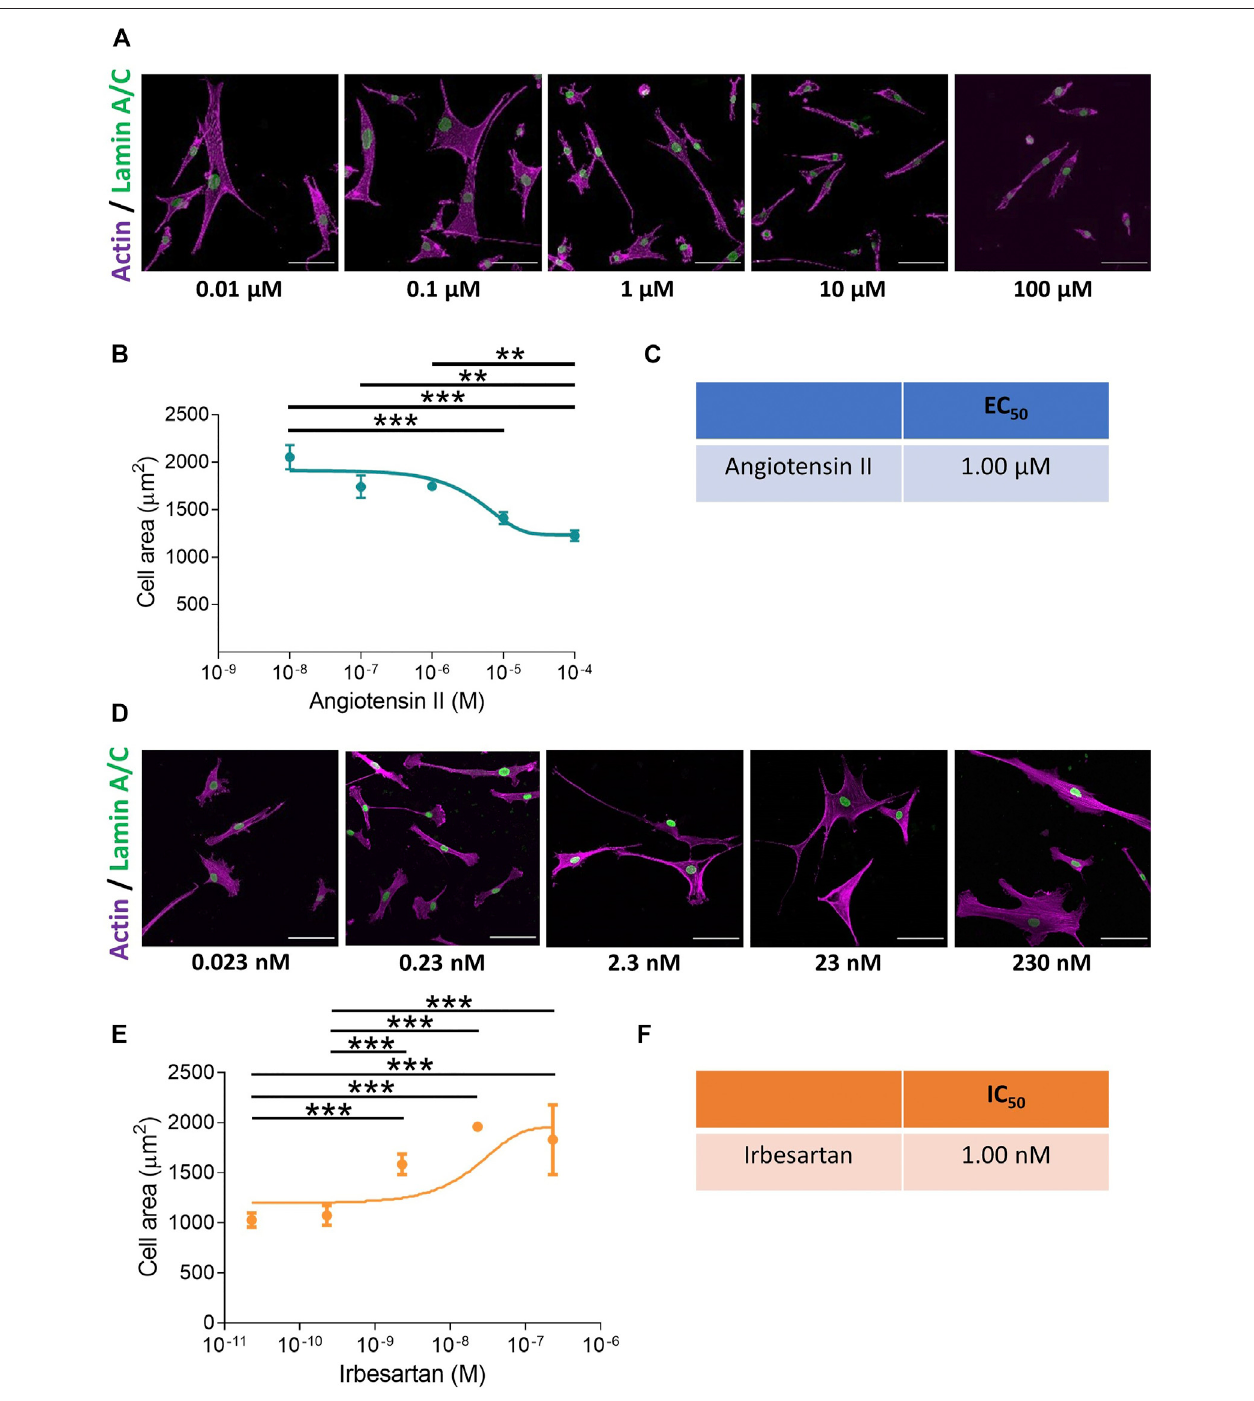
FIGURE 1 | VSMCs grown on pliable hydrogels display decreased area upon stimulation with the contractile agonist angiotensin II. (A) Representative images of isolatedVSMCsculturedon12 kPapolyacrylamidehydrogelstreatedwitharangeofangiotensinIIconcentrationsfor30 min.Actincytoskeleton(purple)andLaminA/C labelled nuclei (green). Scale bar = 100 μ m. (B) Isolated VSMC area, representative of 3 independent experiments with ≥ 150 cells analysed per condition. (C) EC 50 of angiotensin II calculated from (B) . (D) Representative images of isolated VSMCs cultured on 12 kPa hydrogels and treated with angiotensin II (10 µM) for 30 min in thepresenceofarangeofirbesartanconcentrations.Actincytoskeleton(purple)andLaminA/C(green).Scalebar=100 μ m. (E) IsolatedVSMCarea,representativeof3 independent experiments with ≥ 50 cells analysed per condition. (F) IC 50 of irbesartan calculated from (E) . (** = p < 0.01), (*** = p < 0.001).